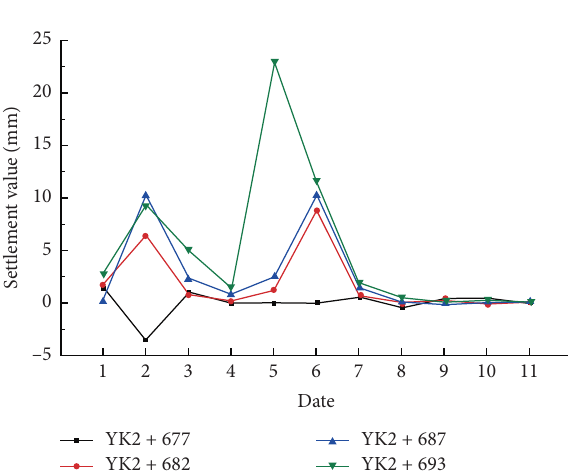
Figure 12: Tunnel vault settlement displacement.